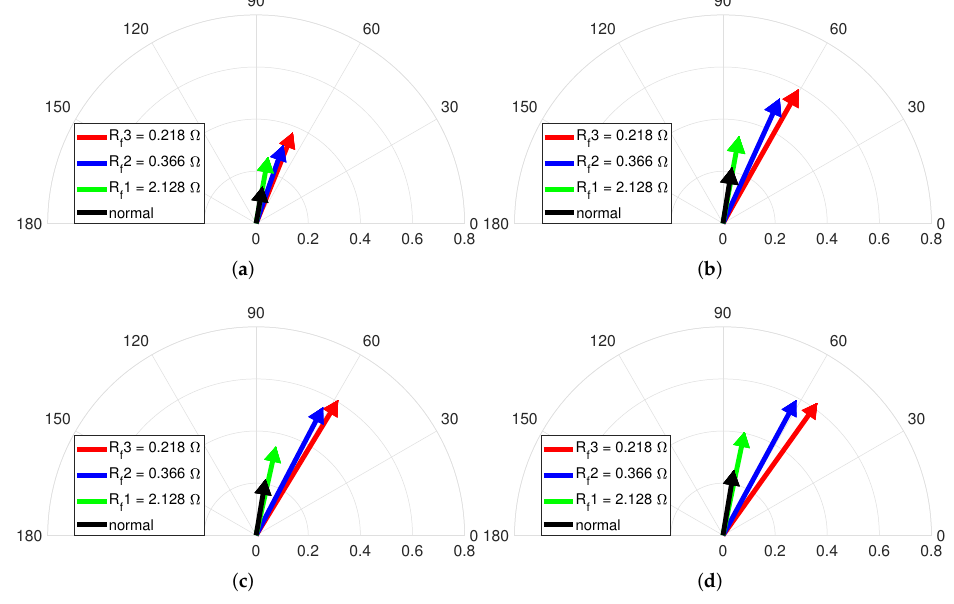
Figure 13. Vector diagram at ( a ) 2000, ( b ) 3000, ( c ) 4000, and ( d ) 4500 rpm and 4.5 Nm with R f